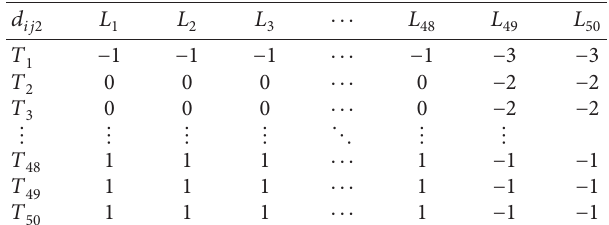
Table 6: Profit and loss matrix F housing location.